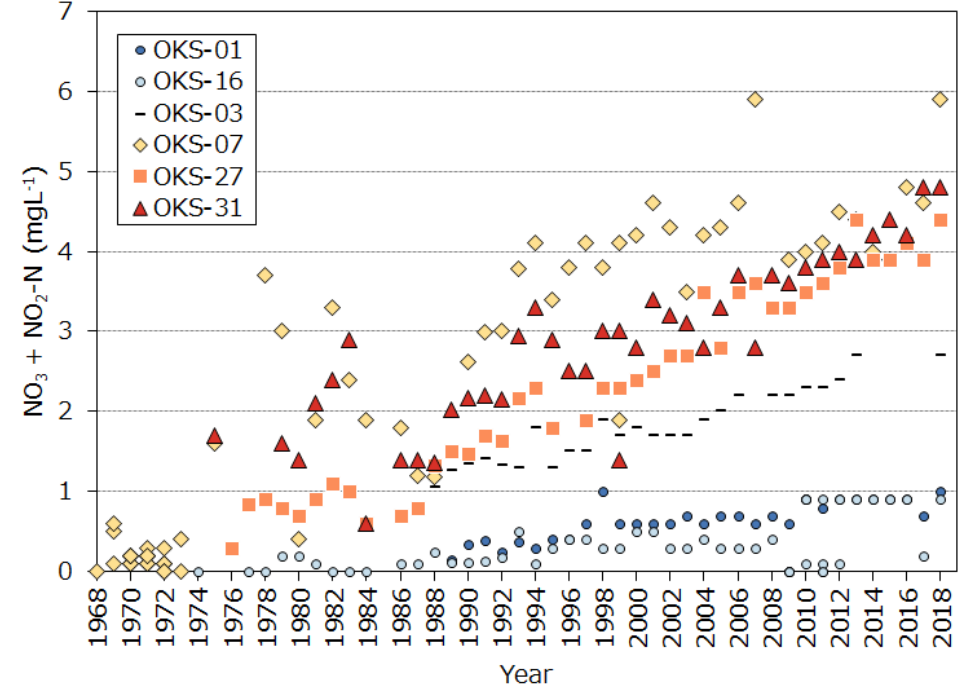
Figure 2. Groundwater nitrate content trend in the Kikuchi area.